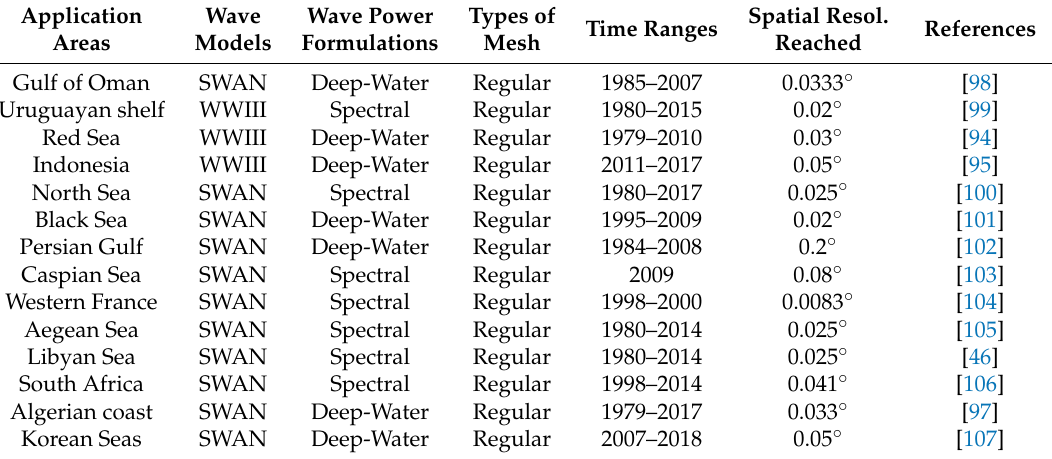
Table 7. Examples of regional numerical wave energy resource